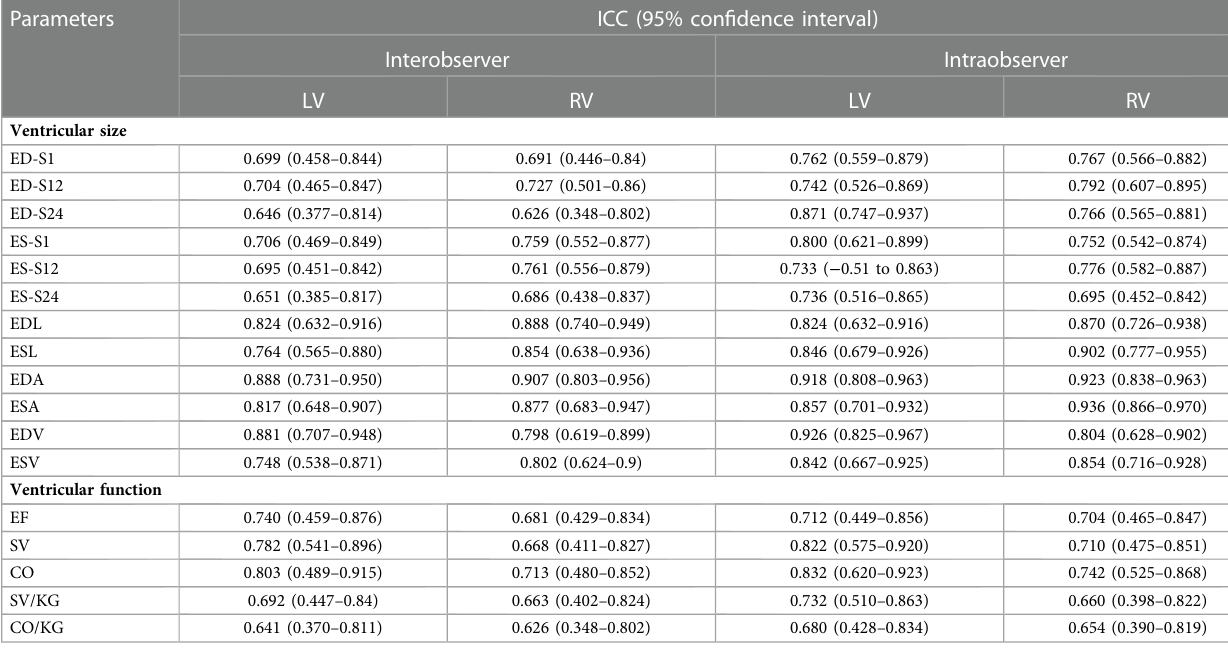
TABLE 2 Intraclass correlation coef fi cients and interobserver and intraobserver variability for fetal cardiac measurements.